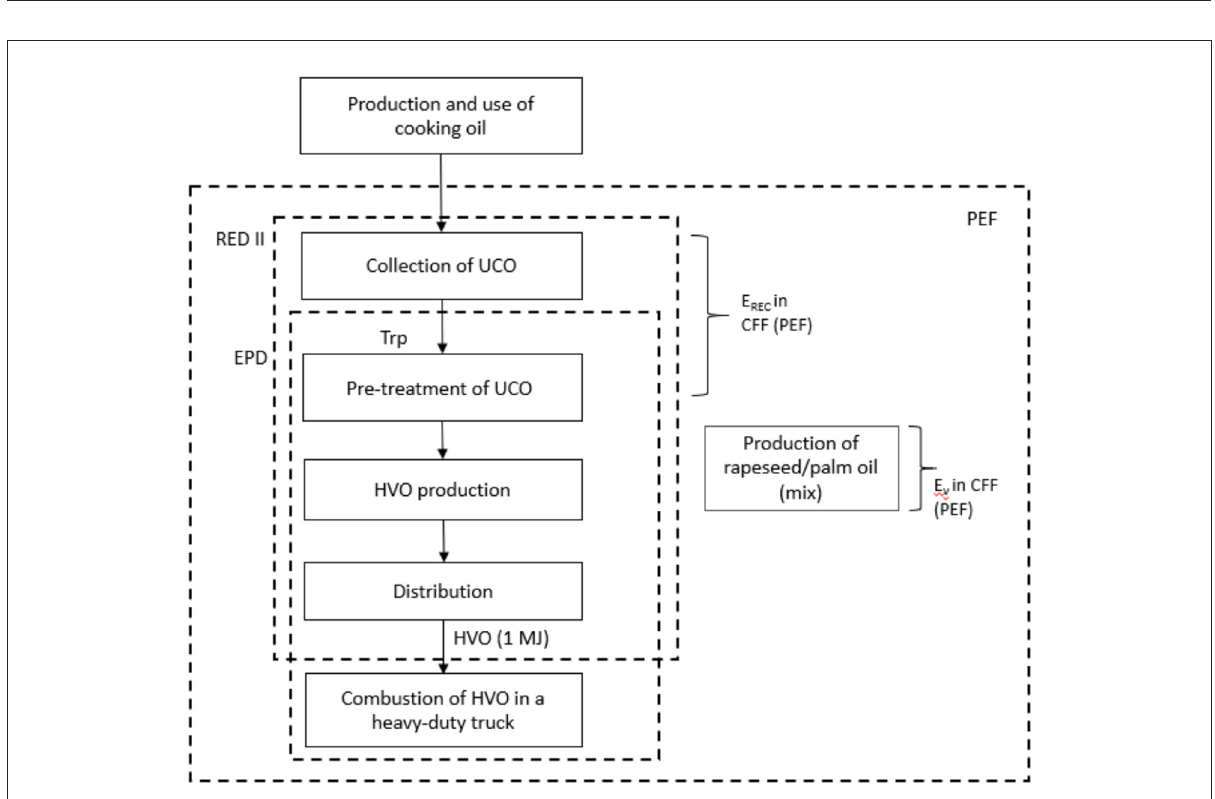
PEF framework considers it as a secondary material. The PEF approach treats recycled material by applying the CFF. As a result, the application of the three frameworks yield different